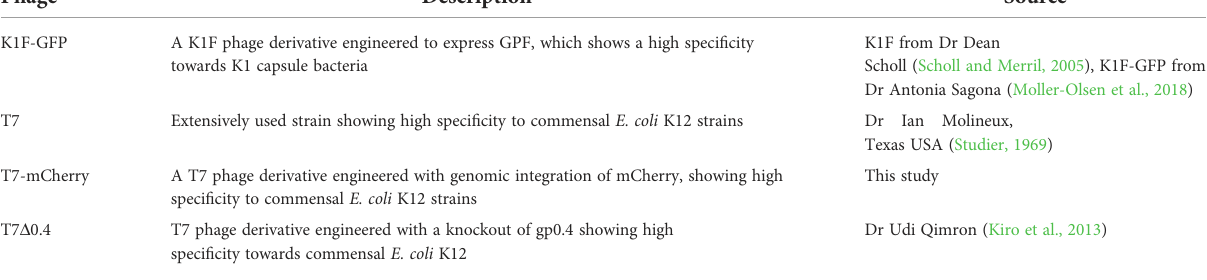
TABLE 2 Phage strains used in this